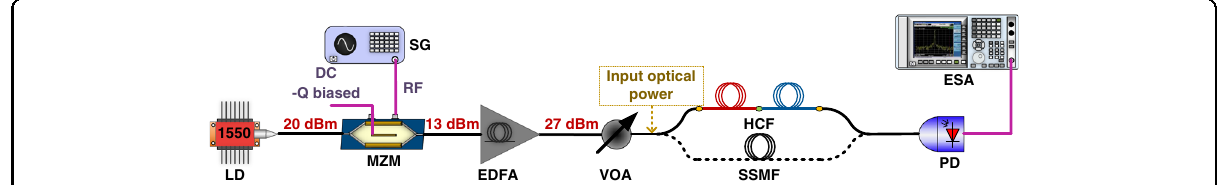
Fig. 2 Quadrature-biased APL set-up. LD, laser diode; EDFA, erbium-doped fi bre ampli fi er; MZM, Mach-Zehnder amplitude modulator; SG, signal generator; VOA, variable optical attenuator; PD, photodiode; ESA, electrical spectrum analyzer. Details of all components are given in the ‘ Methods ’ section